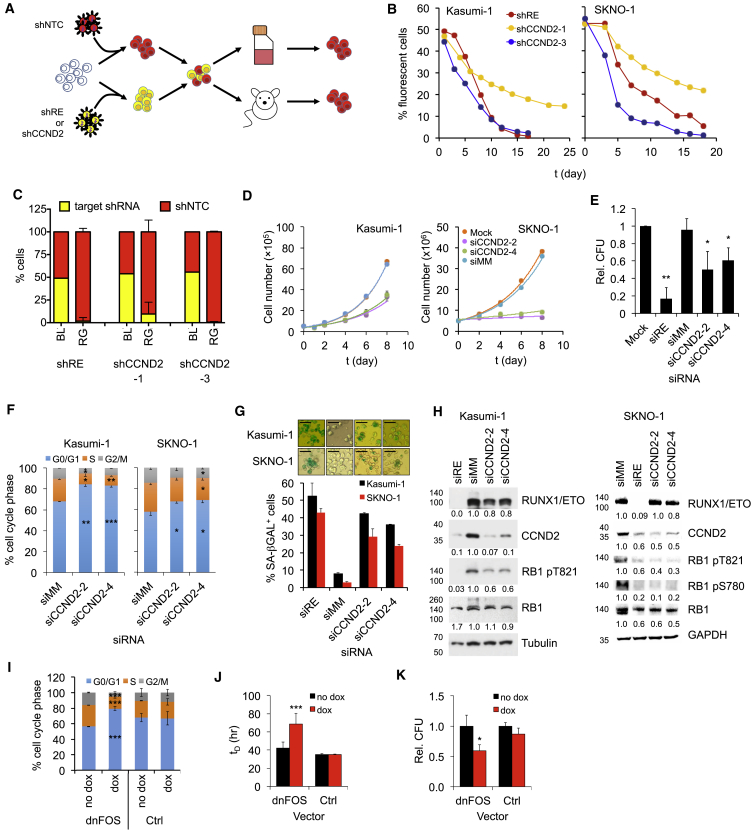
RUNX1/ETO-Expressing AML Cells Are Addicted to CCND2(A) Scheme of the competitive co-culture and transplantation approaches. t(8;21) cells were lentivirally transduced with either a vector linking RPF657 to a non-targeting control shRNA (shNTC) or dTomato to an shRNA targeting either RUNX1/ETO (shRE) or CCND2 (shCCND2-1, −3). Control and knockdown cells were mixed 50:50 followed by co-culture (Kasumi-1 and SKNO-1) or intrahepatic transplantation into newborn RG mice (Kasumi-1). shRE, RUNX1/ETO shRNA; shCCND2, CCND2 shRNA; shNTC, non-targeting control shRNA.(B) Graph showing percentage of shRE-, shCCND2-1- or shCCND2-3 expressing Kasumi-1 and SKNO-1 cells compared with snNTC expressing cells during LTC.(C) Percentage of Kasumi-1 cells with indicated shRNA in transplanted RG mice. BL, starting pool prior to transplantation; RG, cells harvested from transplanted RG mice humanely killed at clinical endpoints. Mean ± SD, n = 5.(D) Proliferation curves for Kasumi-1 and SKNO-1 cells electroporated sequentially every two days with the indicated siRNAs. Mock; non-siRNA electroporated cells; siCCND2, CCND2 siRNA; siMM, mismatch control siRNA. Kasumi-1, n = 3, mean ± SD; SKNO-1, n = 1.(E) Colony formation of Kasumi-1 cells transduced with the indicated siRNA constructs at 12 days post plating. CFU, colony-forming unit. Mean ± SD; Kasumi-1, n = 3; ∗∗p < 0.01; ∗p < 0.05 compared with Mock.(F) Cell cycle distribution of Kasumi-1 and SKNO-1 cells with and without CCND2 knockdown. Mean ± SD; n = 3. Counts at 12 days post plating. Mean ± SD; Kasumi-1, n = 3; ∗∗∗p < 0.001; ∗∗p < 0.01; ∗p < 0.05 compared with siMM.(G) Senescence in Kasumi-1 and SKNO-1 cells as indicated by staining for senescence-associated β-galactosidase (SA-βGAL) after two sequential electroporations with the indicated siRNAs. Top panels, stained cells; bottom panel, quantitation of SA-βGAL+ cell numbers. n = 2 technical replicates; mean ± range. Standard bar, 50 μm.(H) Immunoblots showing the effect of RUNX1/ETO and CCND2 knockdown in Kasumi-1 and SKNO-1 cells on phosphorylation of RB1. Numbers indicate fold changes.(I) Cell cycle distribution of Kasumi-1 cells after 5 days with and without dnFOS induction by doxycycline. Ctrl, empty vector control; dnFOS, dnFOS vector-containing cells. Mean ± SD; n = 3. ∗∗∗p < 0.001 compared with no dox.(J) Impact of dnFOS inductions on cell doubling times (tD). Mean ± SD; n = 3. ∗∗∗p < 0.001 compared with no dox.(K) Impact of dnFOS induction on clonogenicity of Kasumi-1 cells. Colonies were counted 12 days post plating relative to no dox. Mean ± SD; n = 3. ∗p < 0.05 compared with no dox.See also Figure S4.